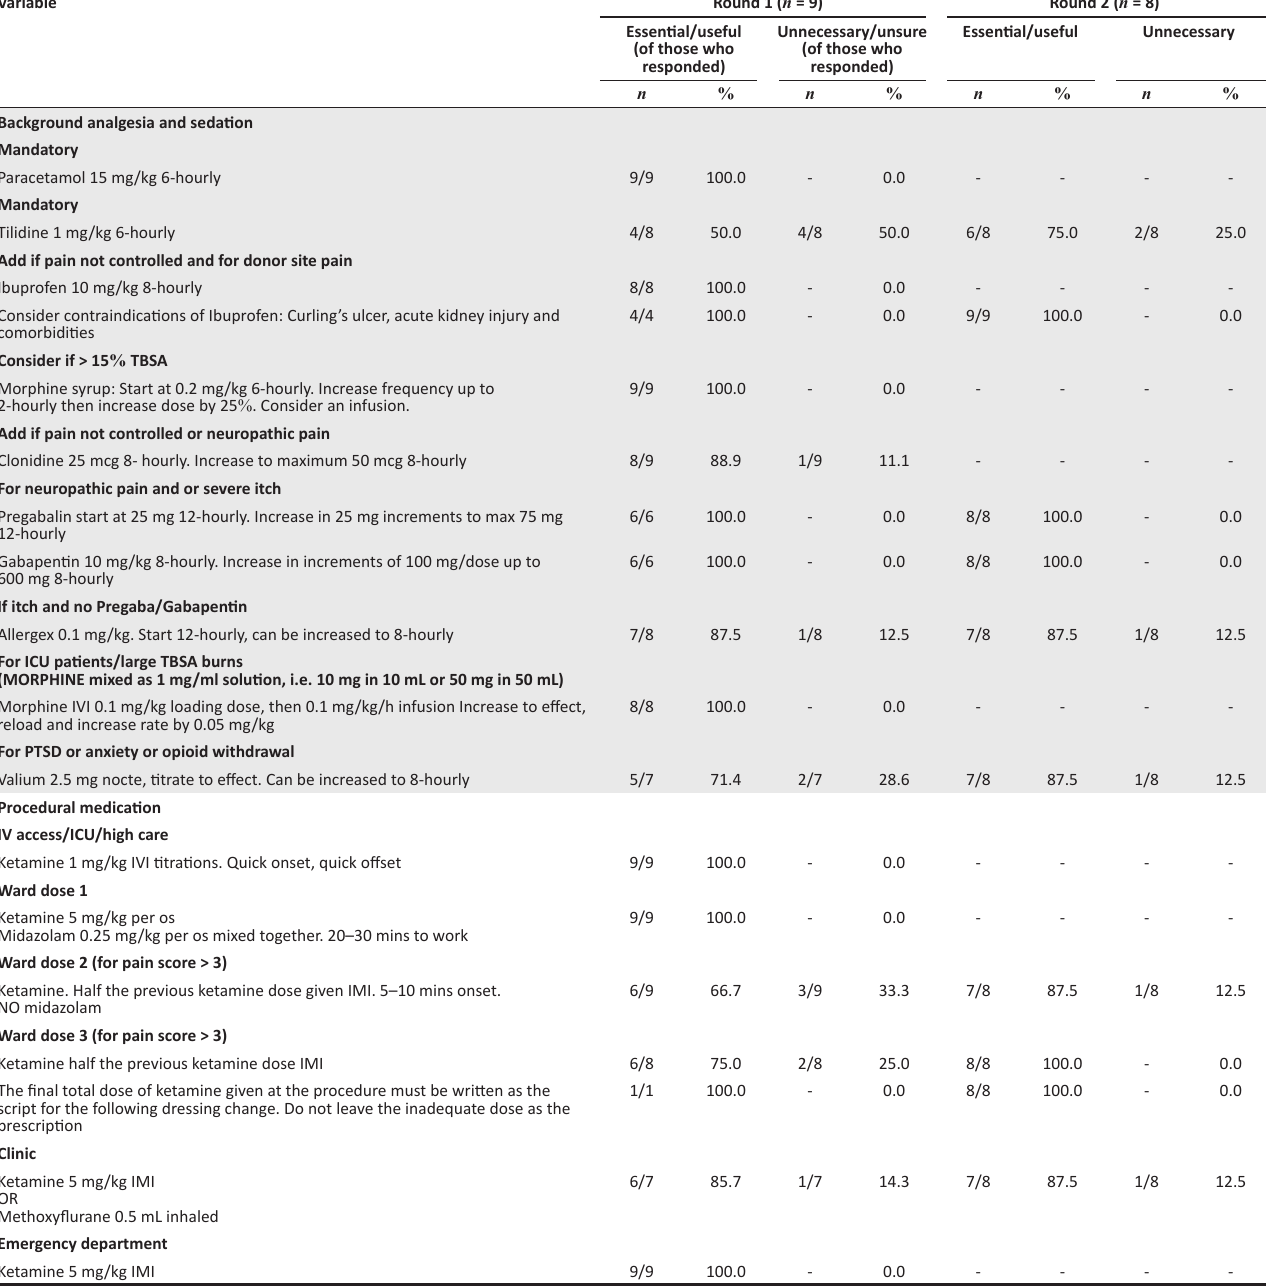
TABLE 1: A summary of the consensus for each of the drug items across the two rounds . Variable